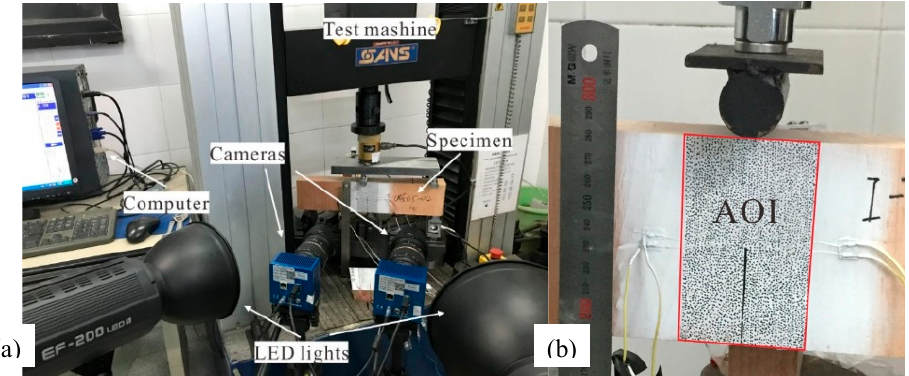
Figure 3. ( a ) Two cameras used to capture images continuously; ( b ) the area of interest (AOI) and speckle pattern on specimen surface.